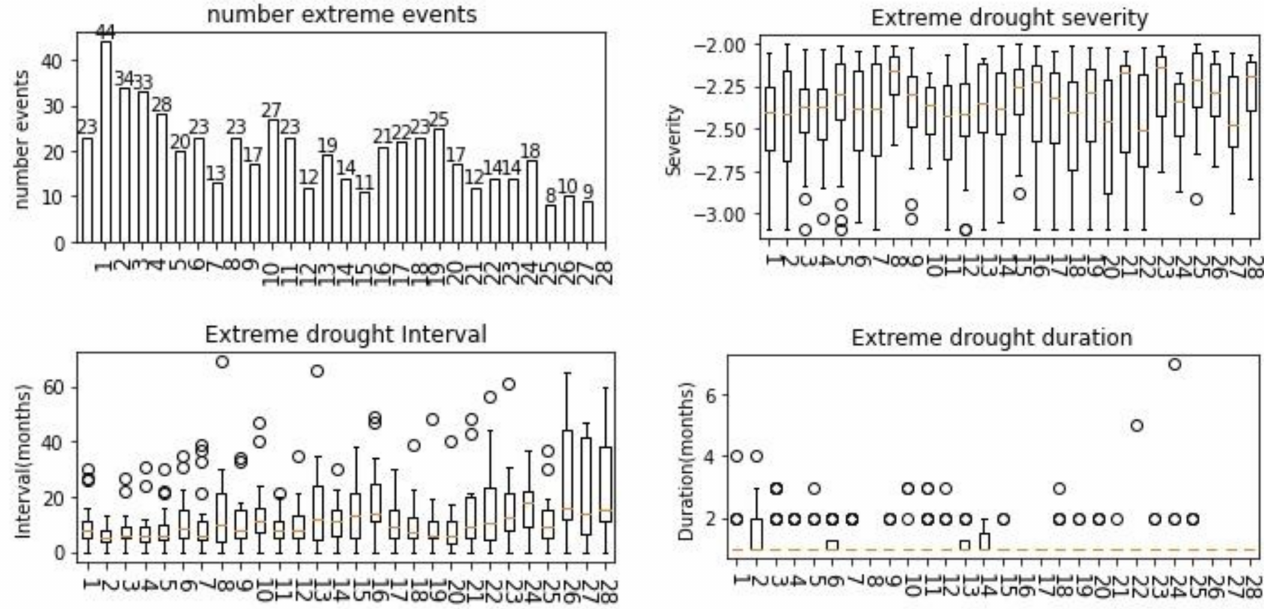
Figure 7. Extreme drought events, interval duration, drought severity, and drought duration for the